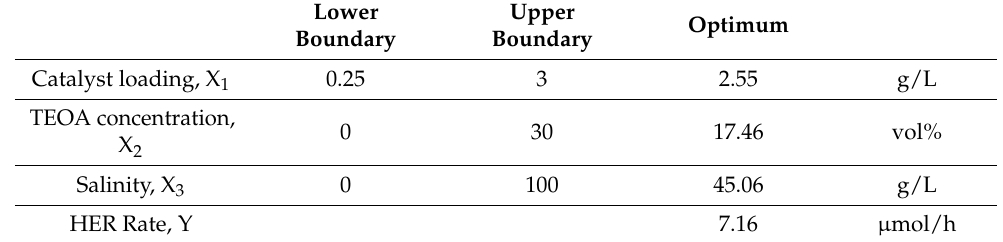
Table 5. The optimum conditions for HER via numerical optimization.